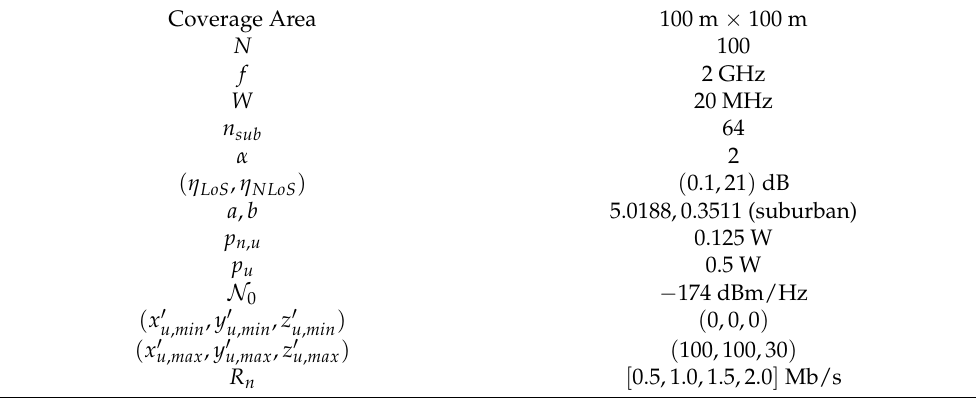
Table 1. Simulation parameters.